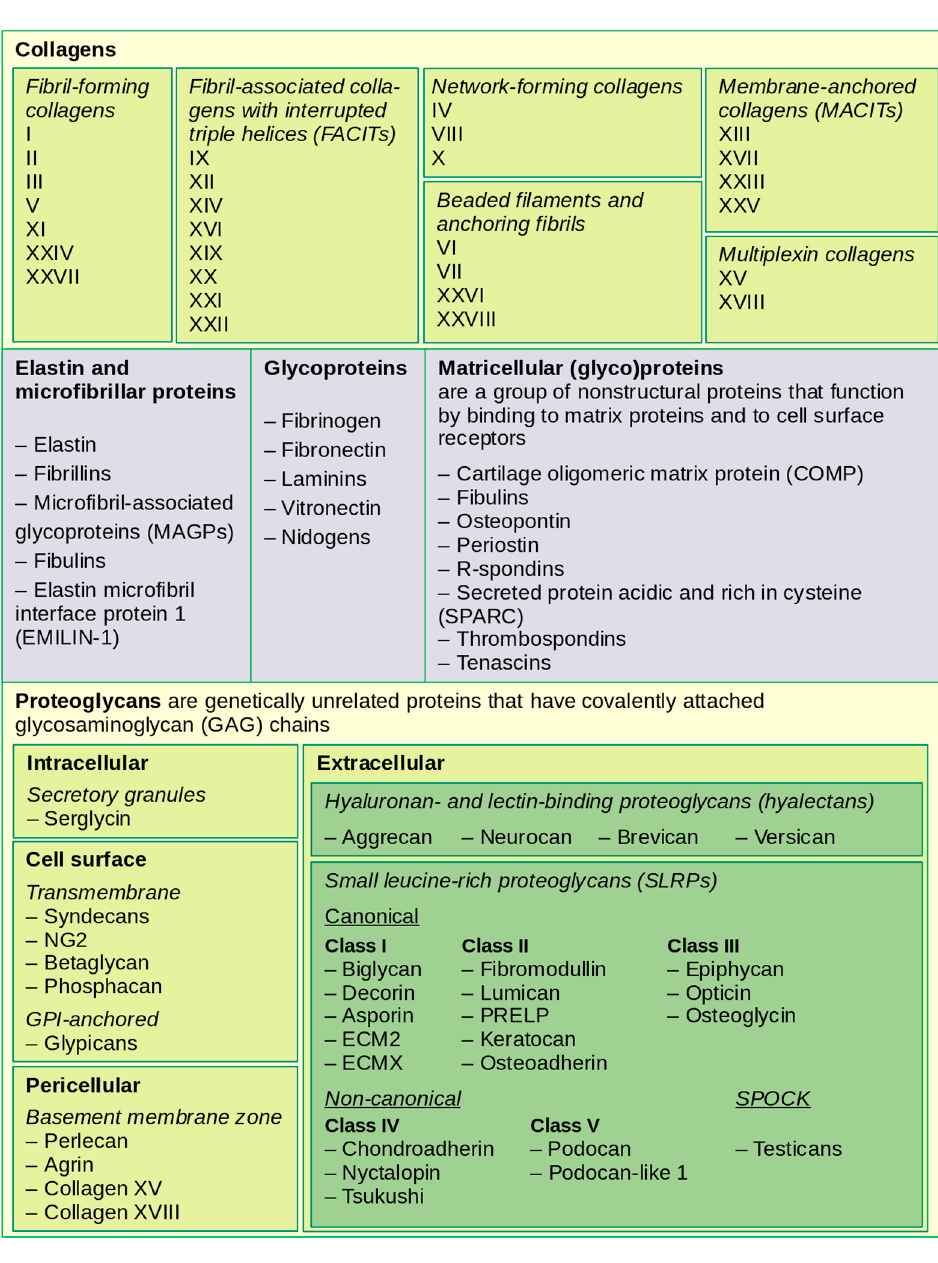
Figure 2. Structural-functional classification of matrix proteins (based on [13,18,24–26]). Interactions of cells with the ECM are mediated by their surface receptors, such as integrins, syndecans and discoidin domain receptors (DDRs) [8]. The family of integrins that are the main cell adhesion receptors for components of ECM includes at least 24 transmembrane heterodimers generated from a combination of non-covalently paired α - and β -subunits. Based on ligand substrate, integrins can be classified into receptors recognizing Arg-Gly-Asp (RGD) peptide motifs, collagen, laminin or leukocyte-specific integrins [27,28]. Integrins are bi-directional signaling receptors involved in outside-in and inside-out signaling. The inside-out signaling mainly acts to bring the integrin into the active conformation [29]. Upon ligand binding, integrins undergo conformation changes leading to outside-in signaling. Ligand-bound integrins engage the actin network via talin and additional cytoskeletal linker proteins, leading to integrin clustering and the following activation of focal adhesion kinase (FAK), Src-family protein tyrosine